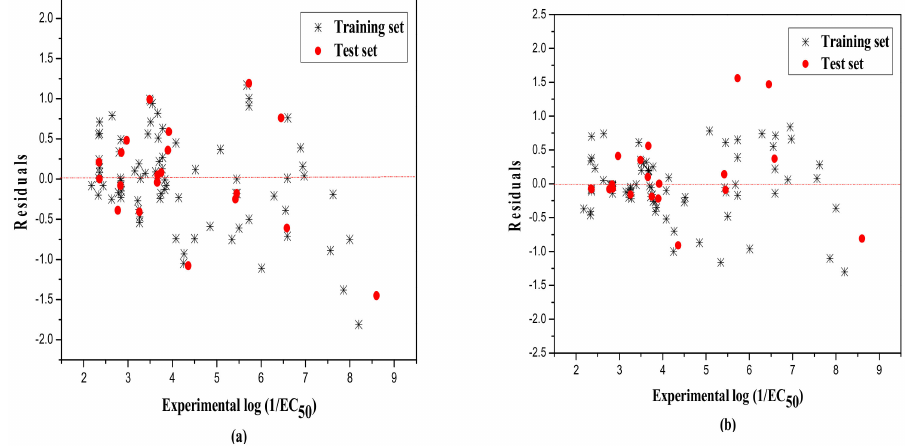
Figure 2. Residuals of the training and test set by MLR ( a ) and RBFNN ( b